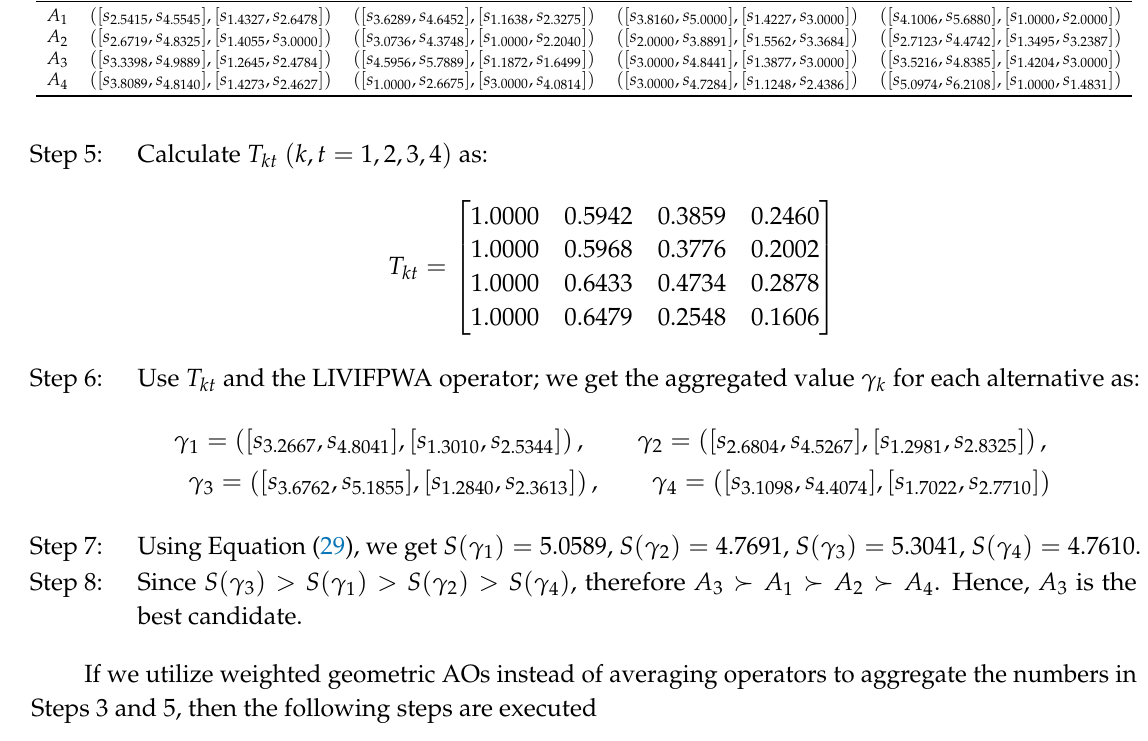
Table 4. Aggregated linguistic interval-valued intuitionistic fuzzy decision matrix R by using the LIVIFPOWA operator. G